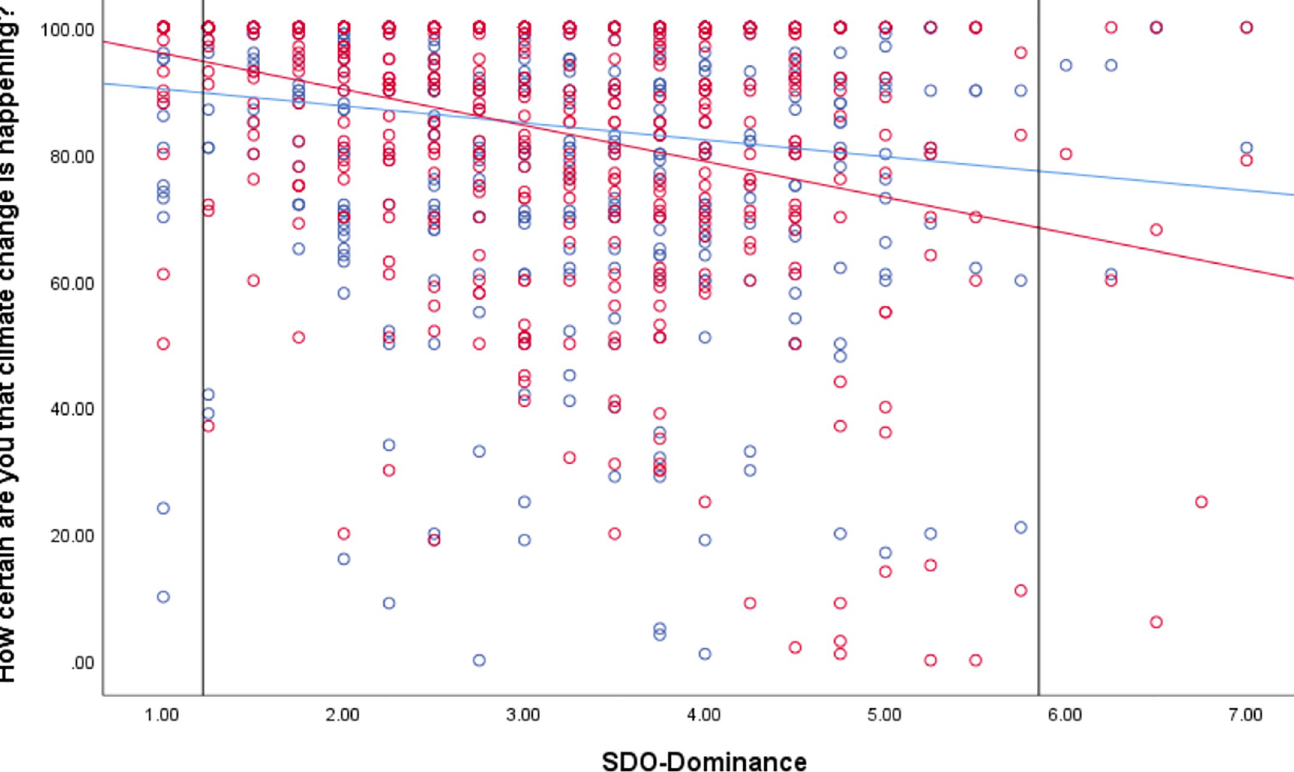
PLOS ONE | https://doi.org/10.1371/journal.pone.0246058 February 11,